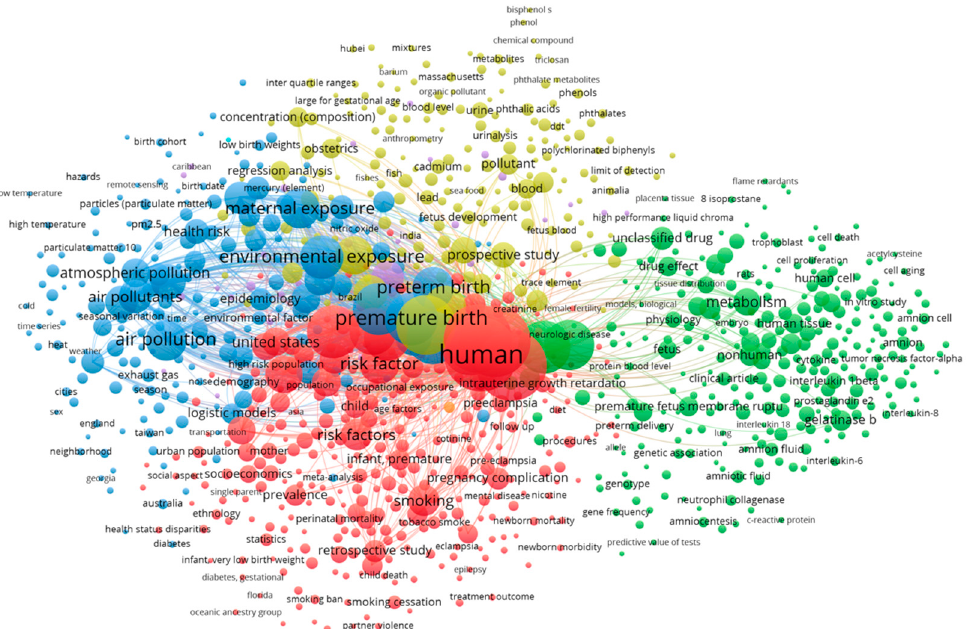
Figure 6. Co-occurrence network showing four clusters of keywords relating to human studies (red), air and particulate matter pollution (blue), environmental pollutants (yellow), and molecular studies on non-human and tissue/cellular samples (green).